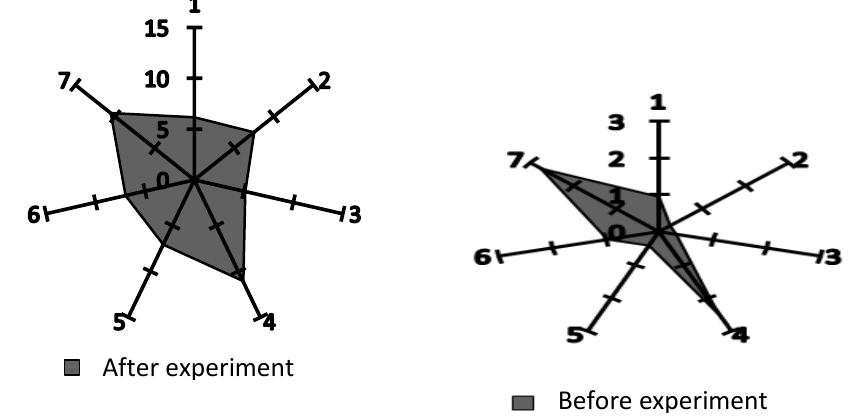
Fig.4. Models of cadets’ psycho-physiological fitness before and after experiment (by Stjudent’s criterion): 1- simple response to light; 2- simple response to sound; 3- sensing of time; 4- sensing of space; 5- operative memory; 6- scope of attention; 7- operative